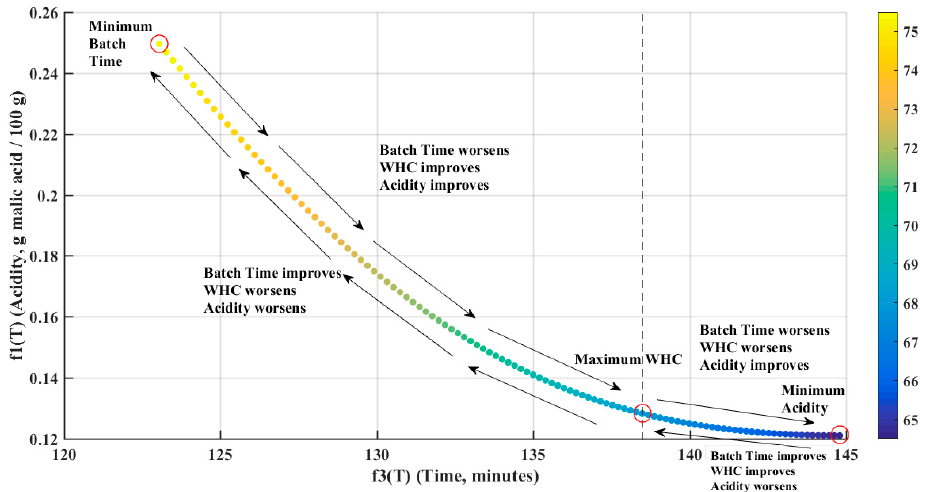
Figure 10. X–Z plane for time and acidity, respectively, of the Pareto-optimal front.